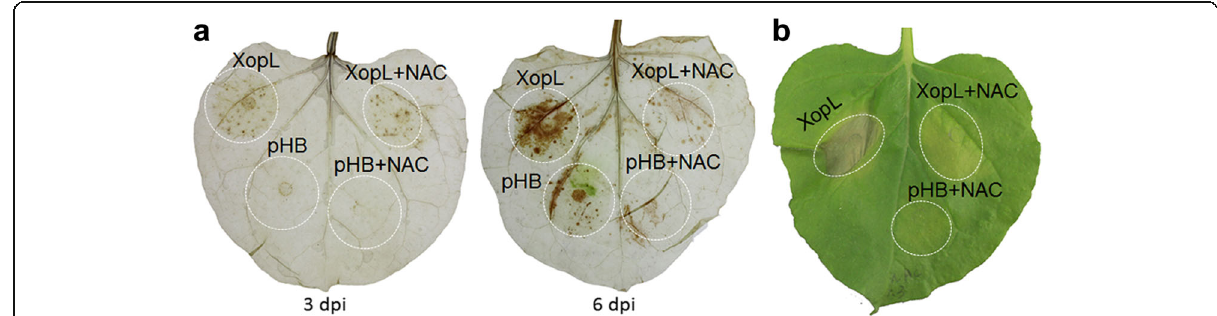
Fig. 6 Effect of the ROS scavenger N-acetyl-L-cysteine (NAC) on XopL-induced cell death. Agrobacterium strains harboring pHB-xopL or empty pHB were inoculated into the wild-type Nb leaves at OD 600 = 1.0; NAC was co-infiltrated at a concentration of 2 mM. a Effect of NAC on XopL- induced ROS accumulation at 3 and 6 dpi. Agrobacterium- infected Nb leaves were collected at 3 and 6 dpi and stained in DAB solution. b Phenotypes of Nb leaves infiltrated with pHB-XopL and pHB, with or without NAC. Pictures were taken at 7 dpi. Experiments were repeated three times with similar